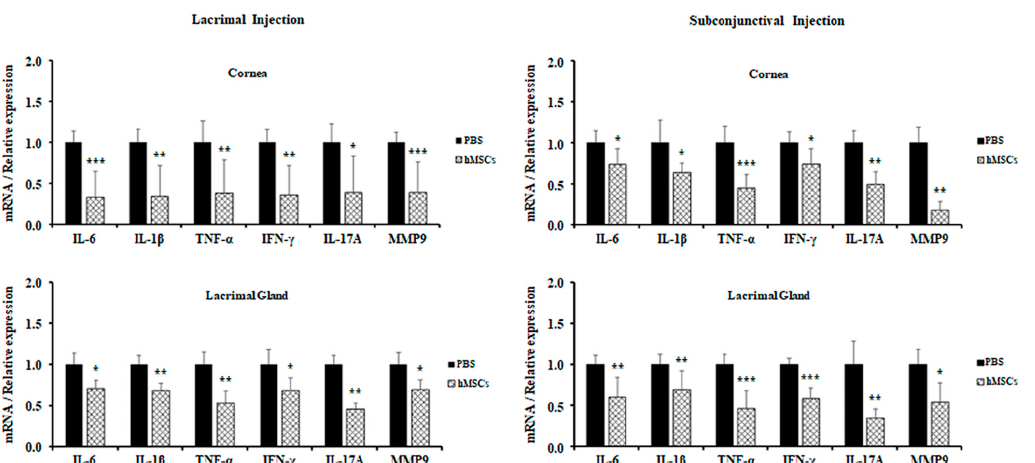
Figure 4. Gene expression of inflammatory cytokines in the cornea and LG of PBS-treated and hMSCs-treated mice. Gene expression levels of inflammatory cytokines were examined in the cornea and conjunctiva and in the lacrimal glands of mice treated with hMSCs or PBS. Data are presented from six independent experiments ( n = 6). * p < 0.05, ** p < 0.01, *** p <